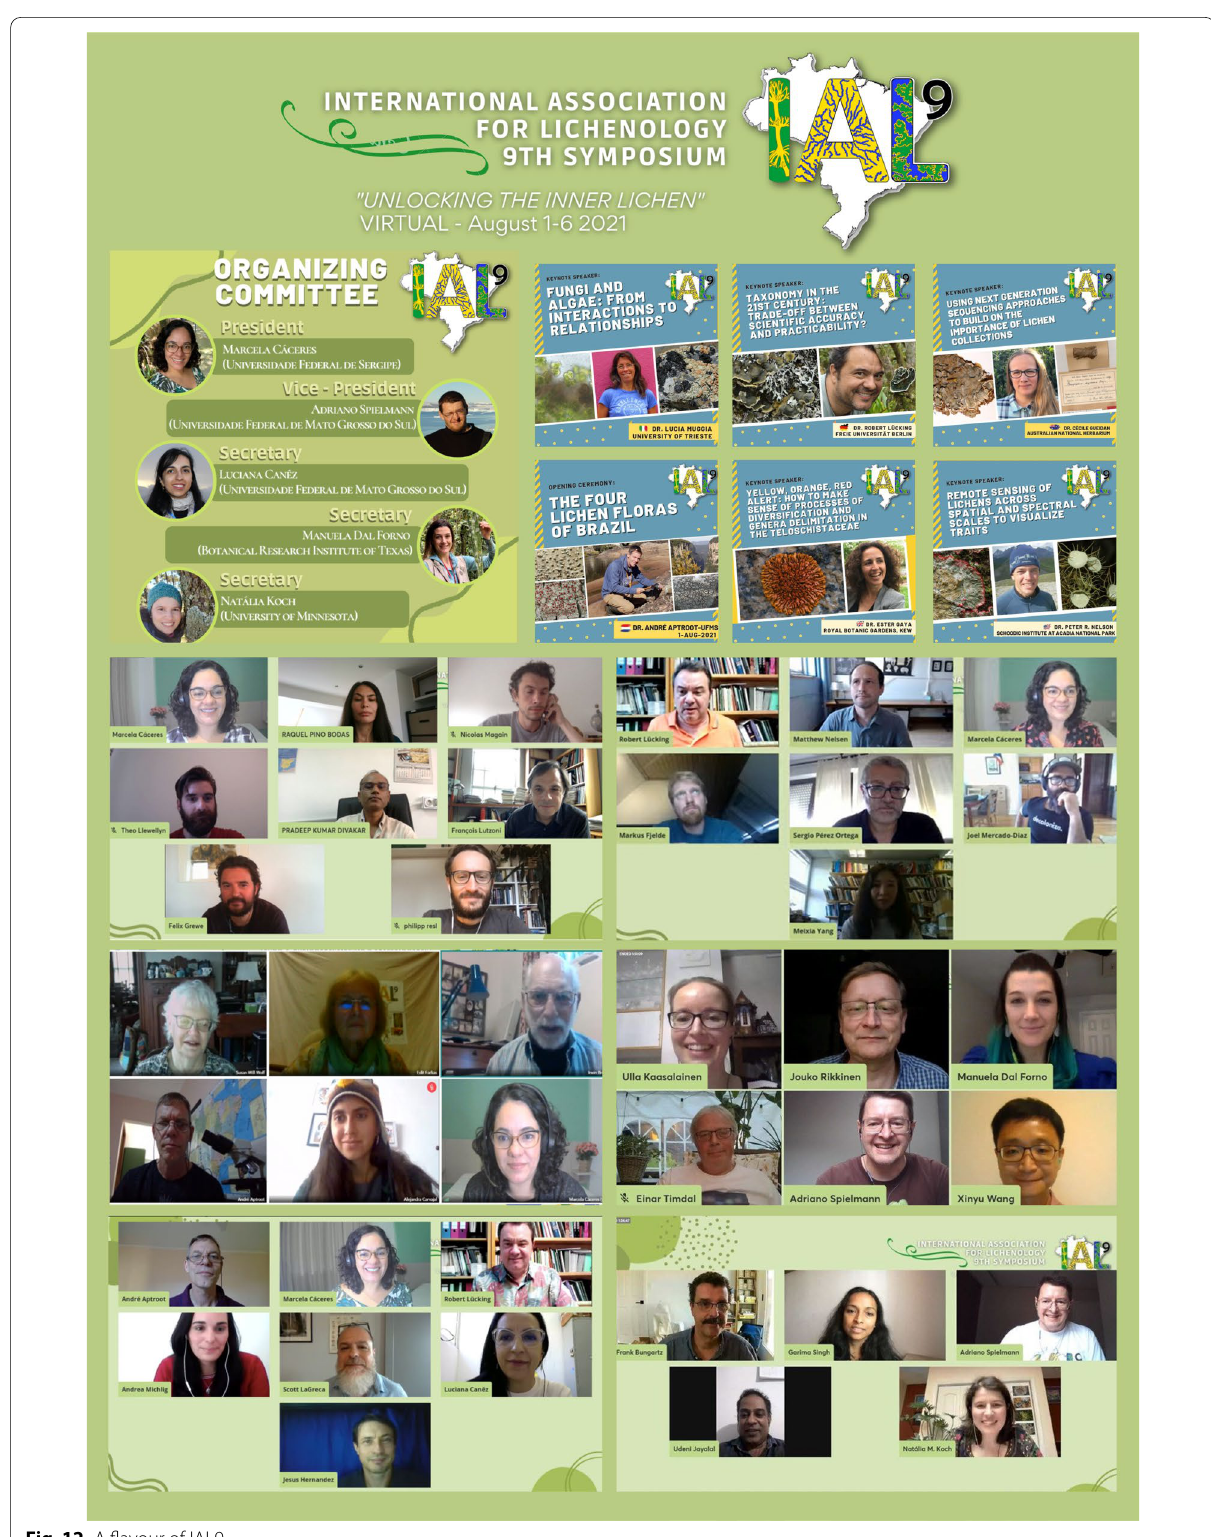
Fig. 12 A flavour of